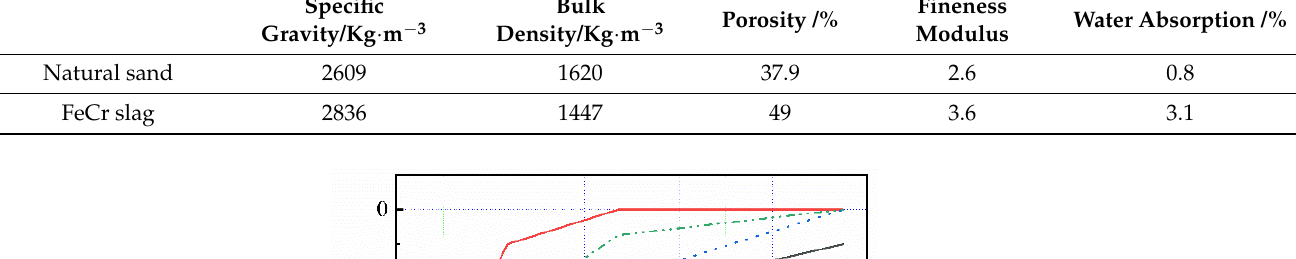
Figure 4. The height curve of the appearance sample point of ferrochrome slag. Table 3. Physical properties of fine aggregates.